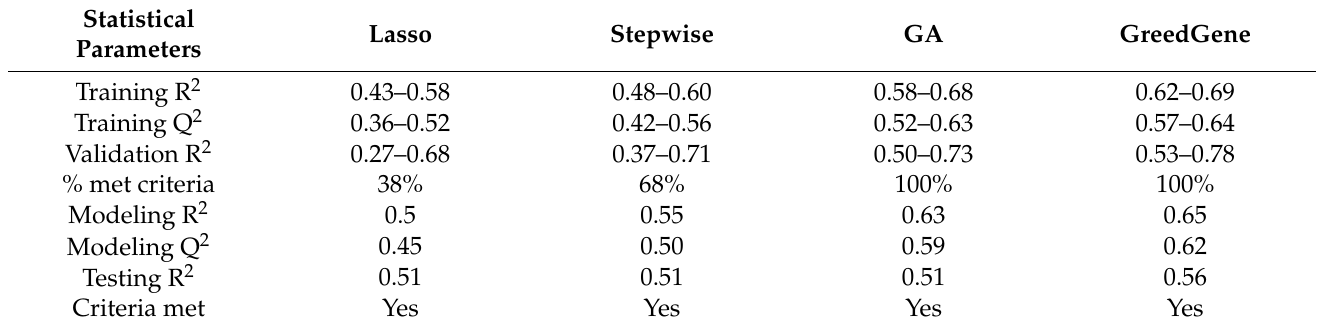
Table 3. List of statistical parameters calculated for each QSAR model using the separate optimization